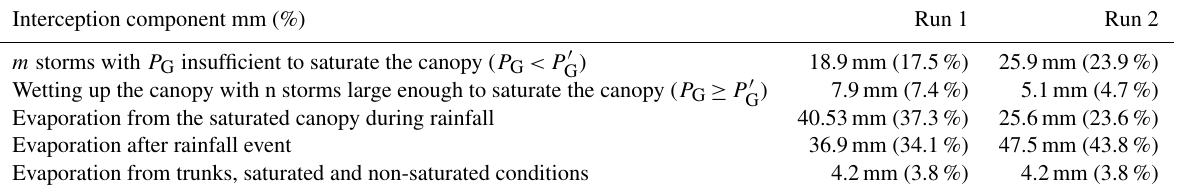
Table 7. Components of interception loss in mm (and as percentage of total) for data-set 2 (19 June to 31 October 2016) based on the validated Gash analytical original